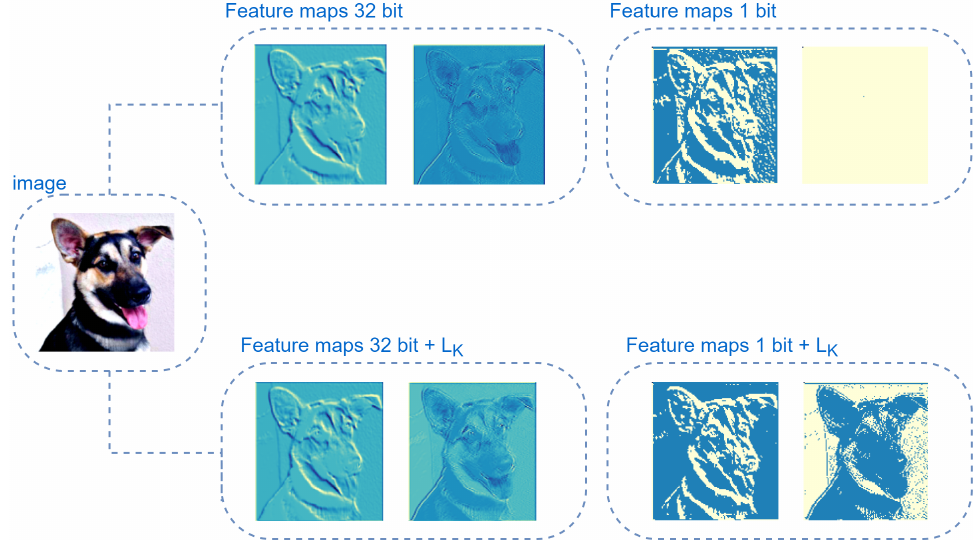
Figure 3. Feature maps taken from the first layer of ResNet-18 trained on an ImageNet dataset. Top row: 32-bit features and binary features from a pre-trained neural network. Bottom row: features trained on ImageNet with the proposed weight distribution regularization ( L K ). While 32-bit feature maps are quite similar, the binary representation of these features lack expressiveness and are less